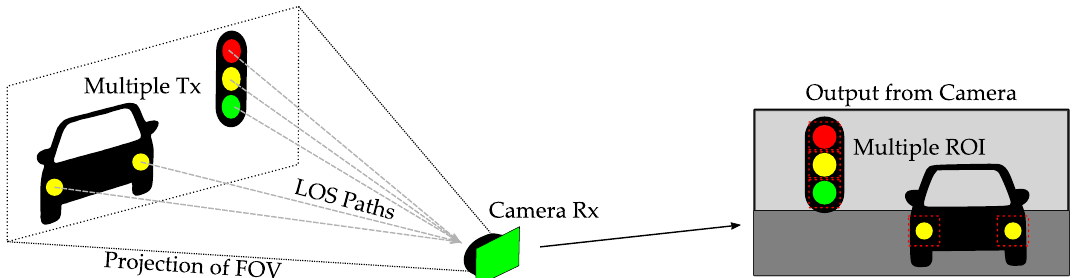
Figure 2. Vehicular visible light communication using OCC is an example of segregation of spatially divided data inputs that is feasible by virtue of the image-forming nature of